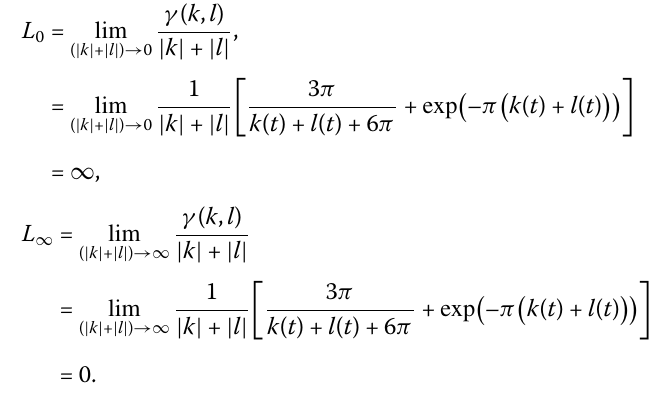
in Assumption (A2) and for 7